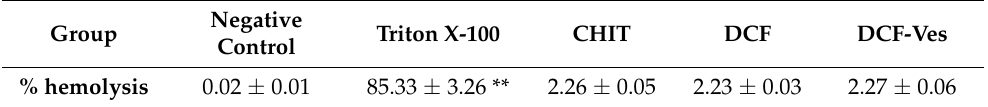
Table 2. In vitro hemocompatibility in CHIT, DCF and DCF-ves. Values were expressed as mean ± S.D. of the mean for 6 animals per group. ** p <0.01 statistically significant compared to the negative control sample. Group